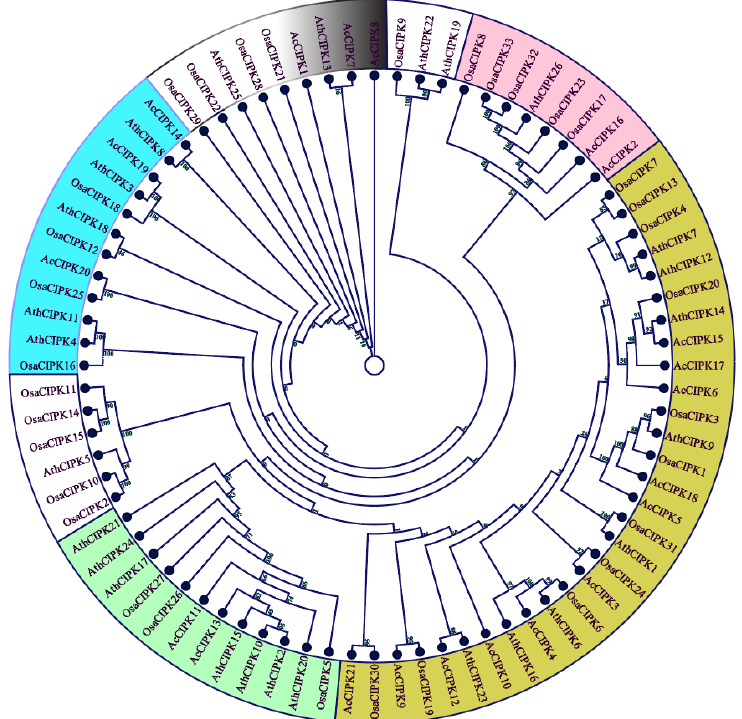
Figure 3. Phylogenetic tree depicting the relationships among CIPK proteins from pineapple, rice, and Arabidopsis . The different colored arcs indicate different subgroups. Prefix ‘Ath’, Osa, and ‘Ac’ indicate CBL proteins from Arabidopsis , Oryza sativa, and Ananas comosus respectively.